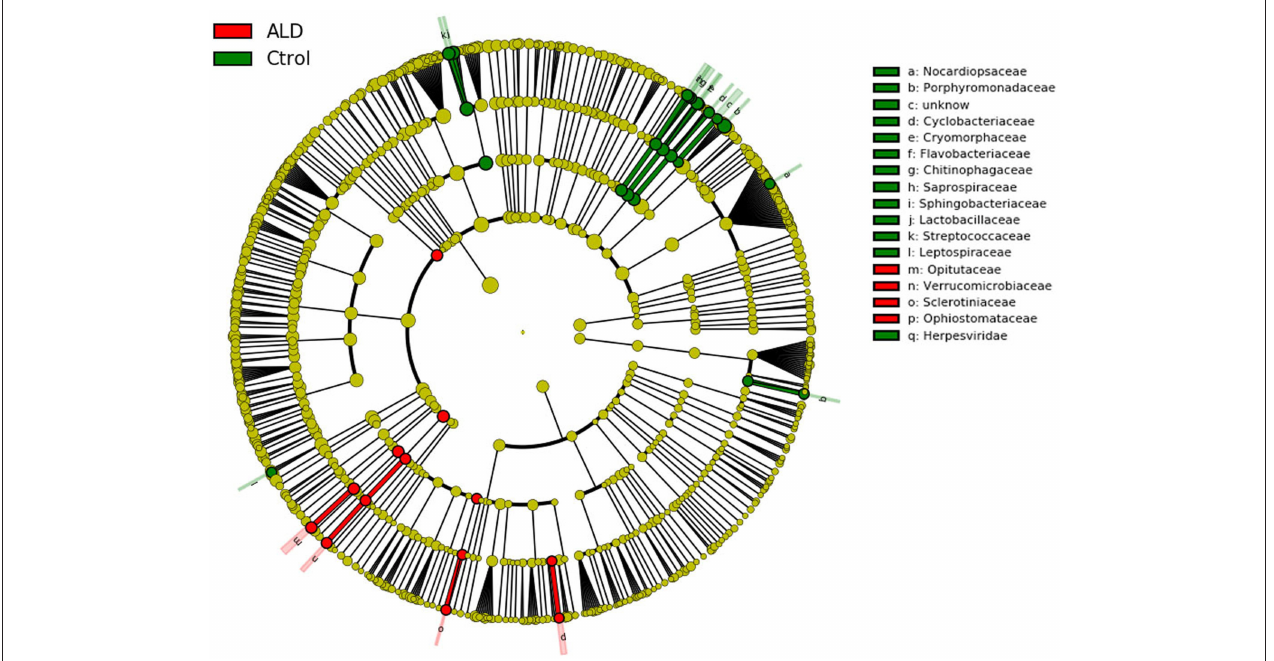
FIGURE 5 | Cladogram using LEfSe method indicating the phylogenetic distribution of fecal microbiota associated with ALD and control